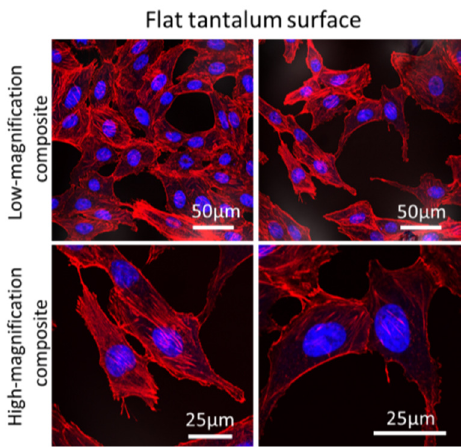
Figure 2. Fluorescence confocal micrographs show cell nuclei (blue) and actin micro-filaments (red) randomly oriented on blanket tantalum surfaces.